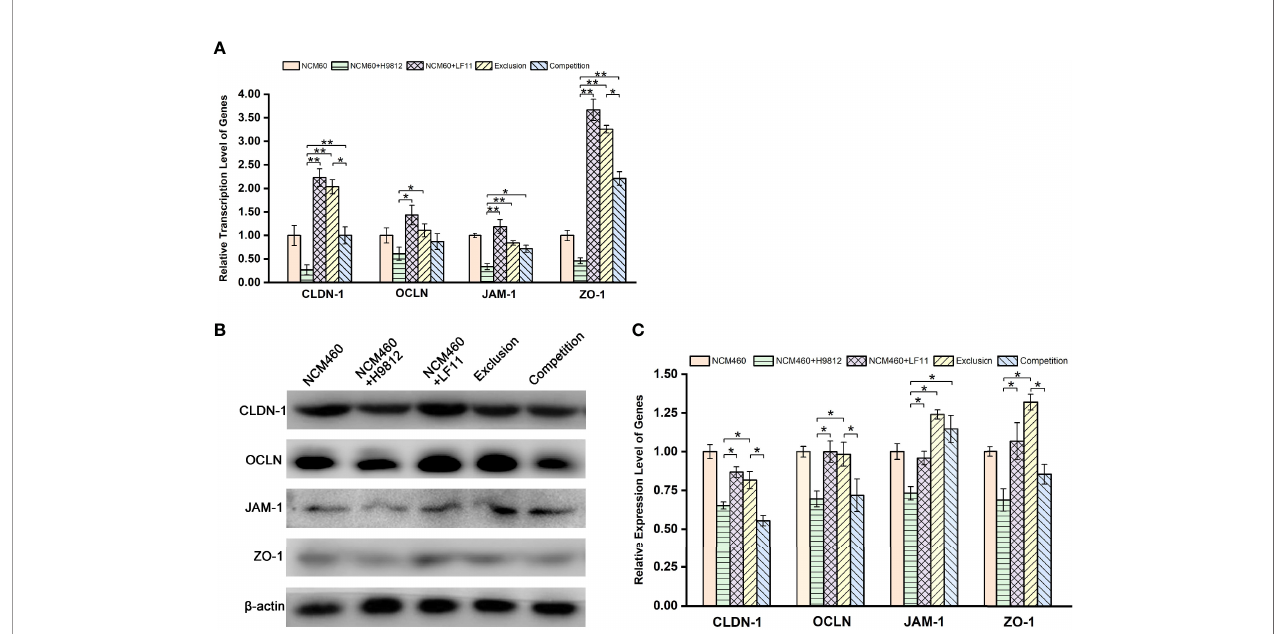
FIGURE 3 | B. subtilis LF11 enhances the gene transcription and expression of tight junction proteins. (A) Relative transcription levels of CLDN-1 , OCLN , JAM-1 , and ZO-1 genes. (B) Expression levels of tight junction proteins in NCM460 cells incubated with B. subtilis LF11 and S. braenderup H9812 with various treatments by Western blot. Each line represents different treatments. (C) Semiquantitative analysis of the expression of tight junction proteins in corresponding bands. The b -actin was used as the housekeeping gene, the data of relative gene transcription and expression levels were analyzed using the 2 − DD Ct method, and the gene transcription or expression levels of tight junction proteins in control NCM460 cells are de fi ned as 1.0. All data are given as means ± SD for n = 3. * p < 0.05, ** p <